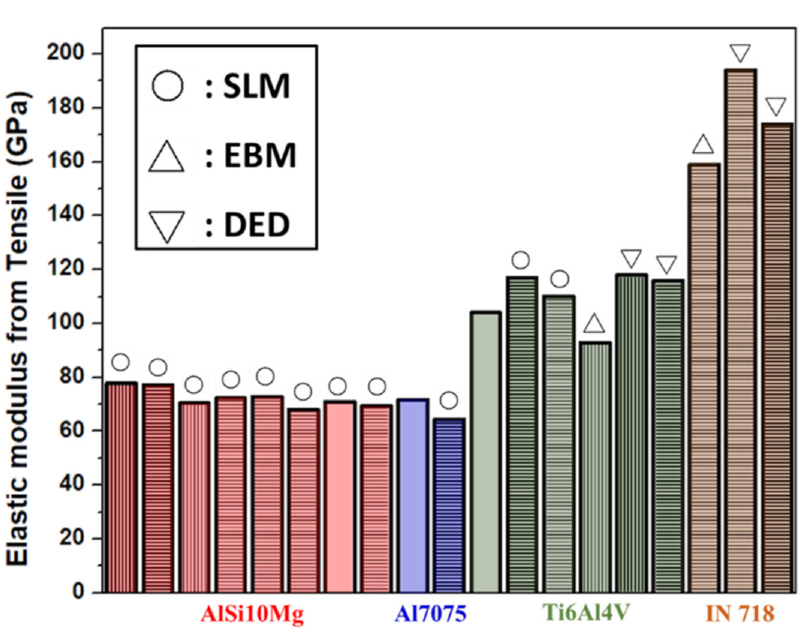
Figure 24. Selected values of tensile elastic modulus from existing literature on metal AM. The horizon- tally patterned bar indicates horizontally printed samples, and the vertically patterned bar indicates vertically printed samples Cast reference values are represented without a pattern